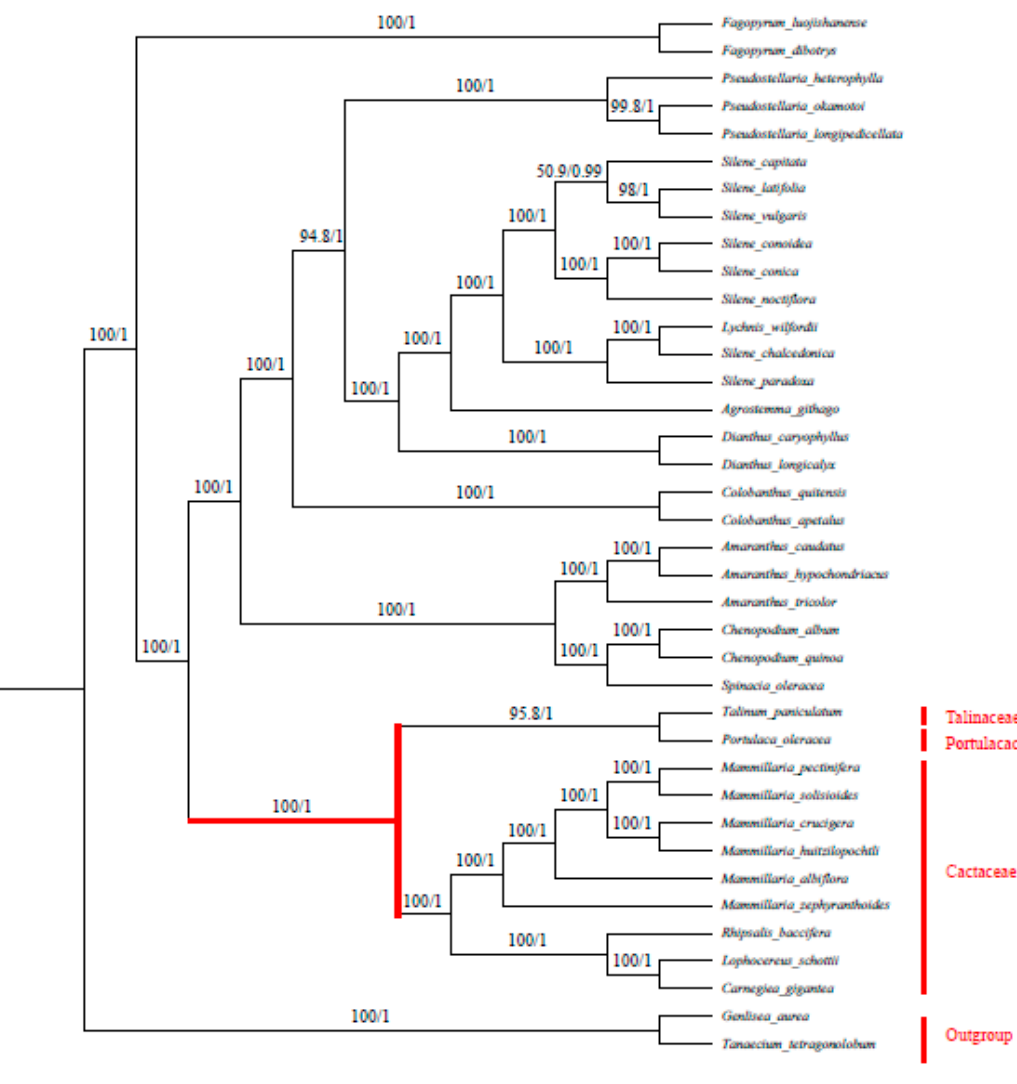
Figure 10. Combined phylogenetic tree of 36 species order Caryophyllales using maximum likelihood (ML) and Bayesian methods based on their complete chloroplast genomes. Two outgroups from order Lamiales were used. The numbers above the nodes are support values with ML bootstrap values on the left and Bayesian posterior probabilities values on the right.